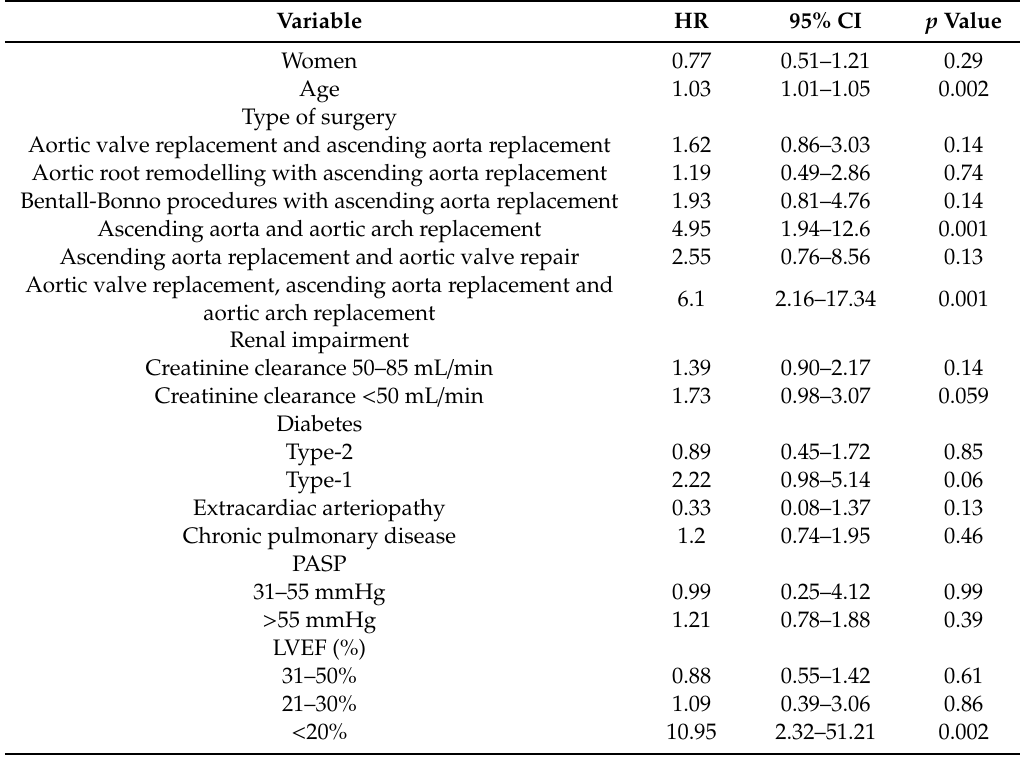
Table 6. Results of the COX regression analysis showing the main risk factors for